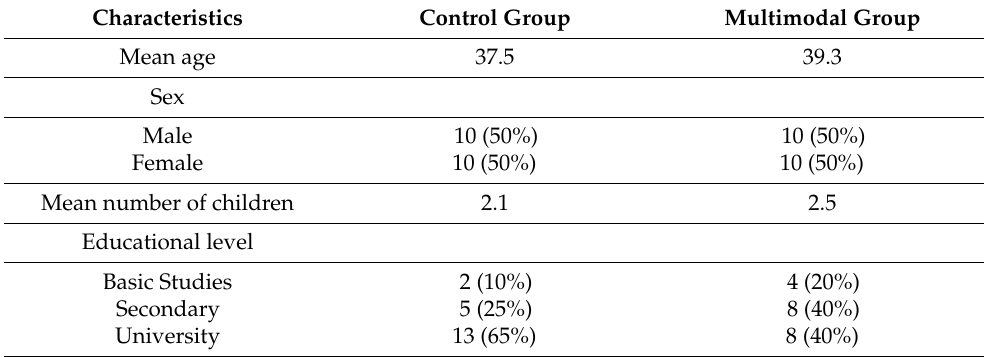
Table 2. Sociodemographic characteristics of the sample of parents.